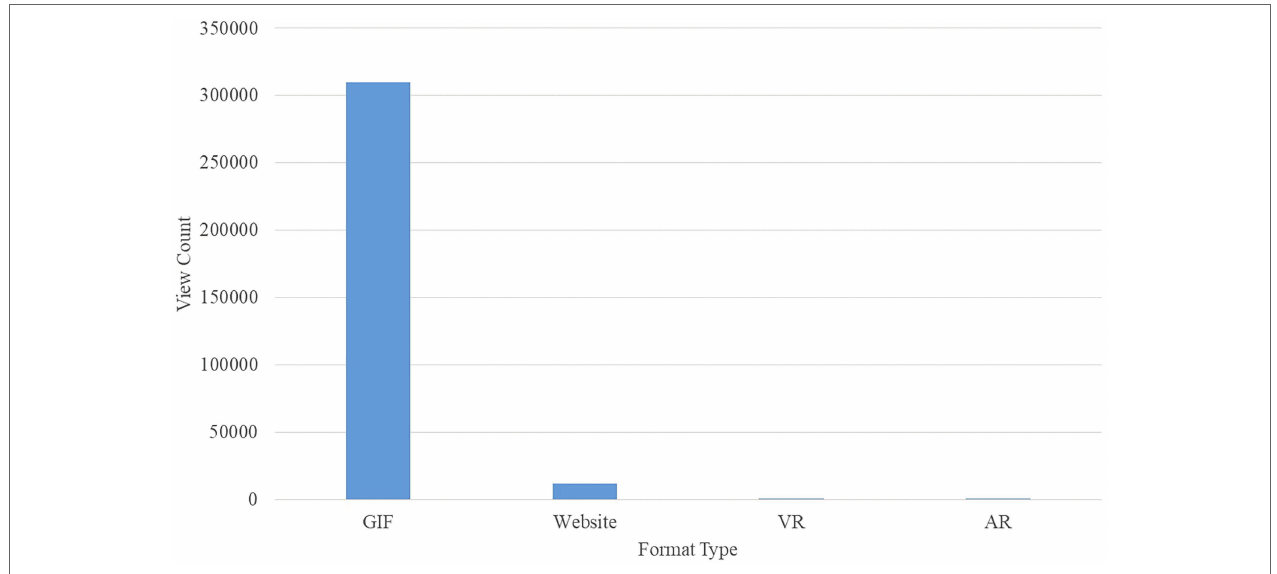
FIGURE 3 | User reach in different formats for one Flow Immersive